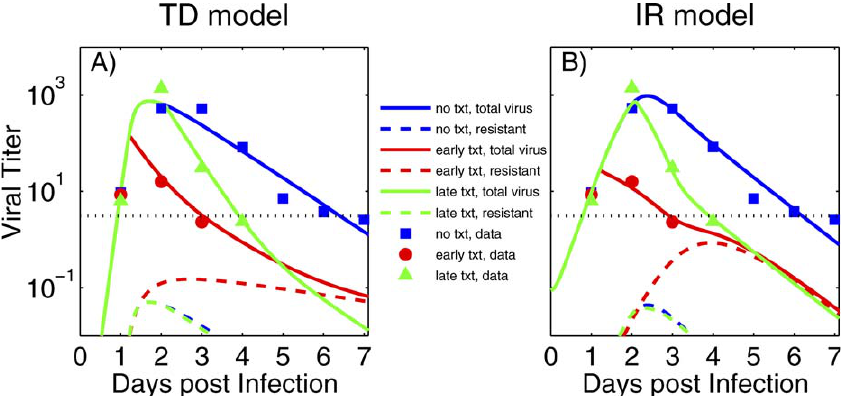
Figure 1. Viral Titer (TCID 50 /ml of Nasal Wash) Symbols in (A) and (B) are data from humans infected with influenza A/Texas/91 (H1N1). Early drug treatment starts at around 29 h, late treatment at around 50 h post-infection. The dotted horizontal line shows the limit of assay sensitivity. The solid lines show total viral load as obtained from (A) the target-cell depletion (TD) model and (B) the immune response (IR) model. The dashed lines show the resistant subpopulation. Further details on the experimental data are given in [27].